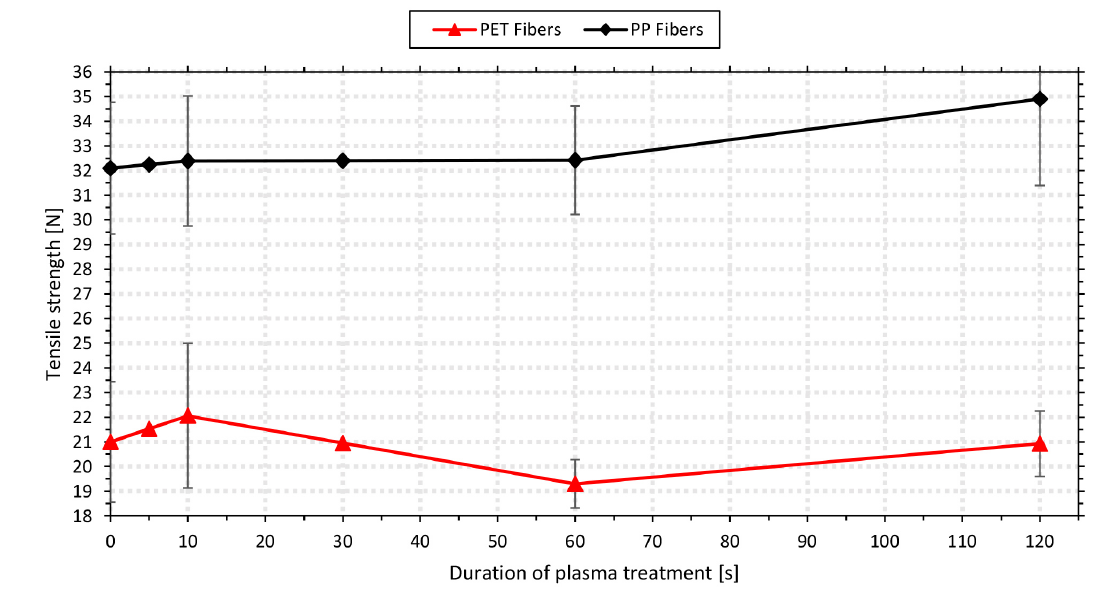
Figure 6. Dependence between fibers tensile strength and duration of plasma